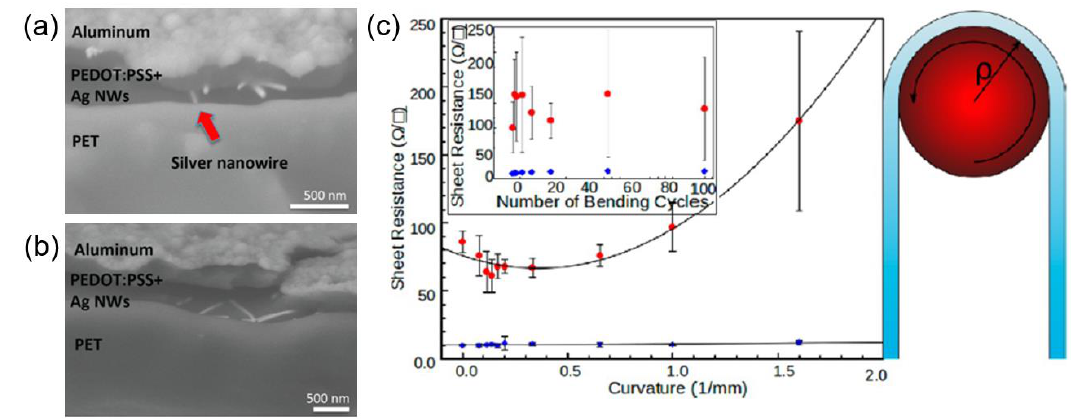
Figure 20. Cross-sectional SEM images of ( a ) PEDOT:PSS/Ag NW (as-sprayed). ( b ) PEDOT:PSS/Ag NW (as-sprayed/rolled). ( c ) Sheet resistance vs. bending of a sample at various bending radii for as-sprayed Ag NW on PET (red) and Ag NW meshes rolled at 165 °C (blue) (inset: Sheet resistance of each sample after bending cycles). Reproduced with permission from [98]. Copyright 2013 American Chemical Society.